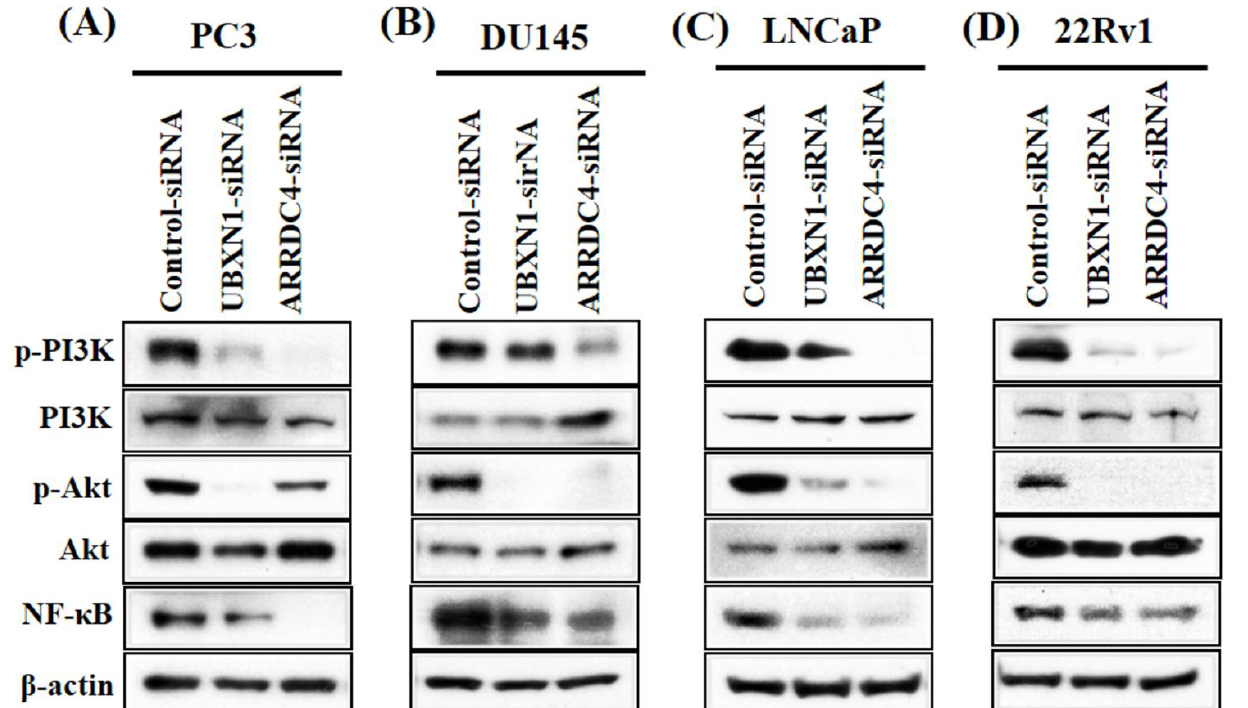
Figure 6. Knockdown of UBXN1 and ARRDC4 inhibits PI3/Akt/NF-kB pathway in prostate cancer cells. PC3 ( A ), DU145 ( B ), LNCaP ( C ), and 22Rv1 cells ( D ) were transfected with siRNA targeted UBXN1 and ARRDC4 or its negative control. The expression of protein was detected by Western blot analysis.